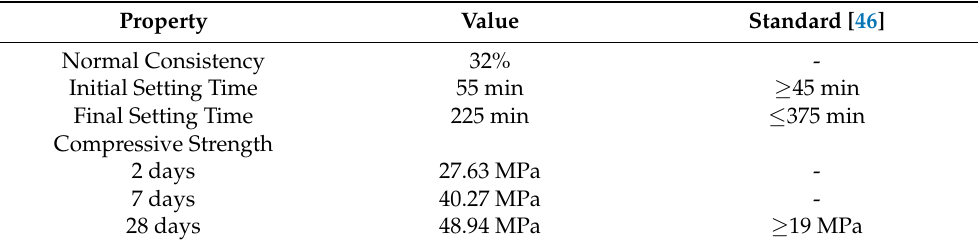
Table 2. Physical and mechanical properties of ordinary Portland cement.